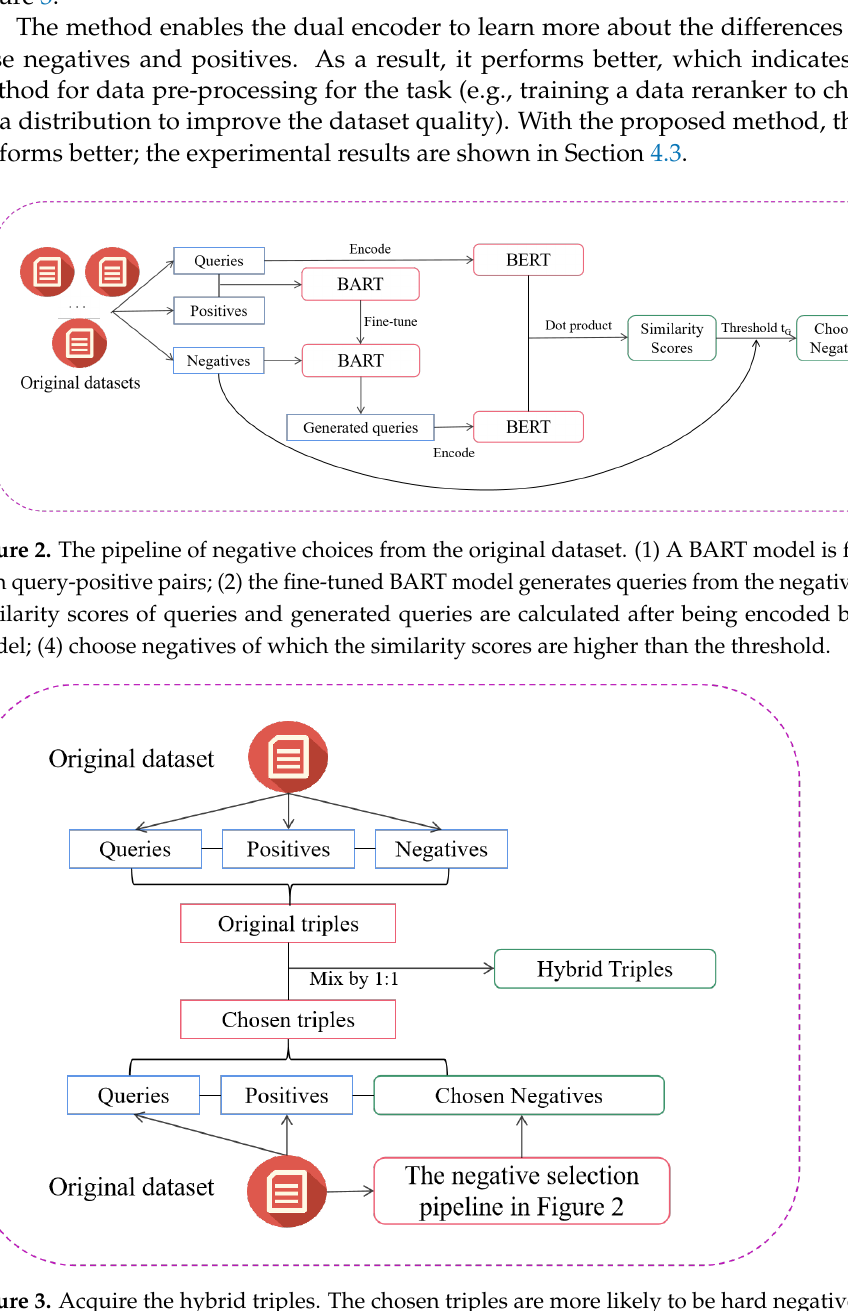
Figure 3. Acquire the hybrid triples. The chosen triples are more likely to be hard